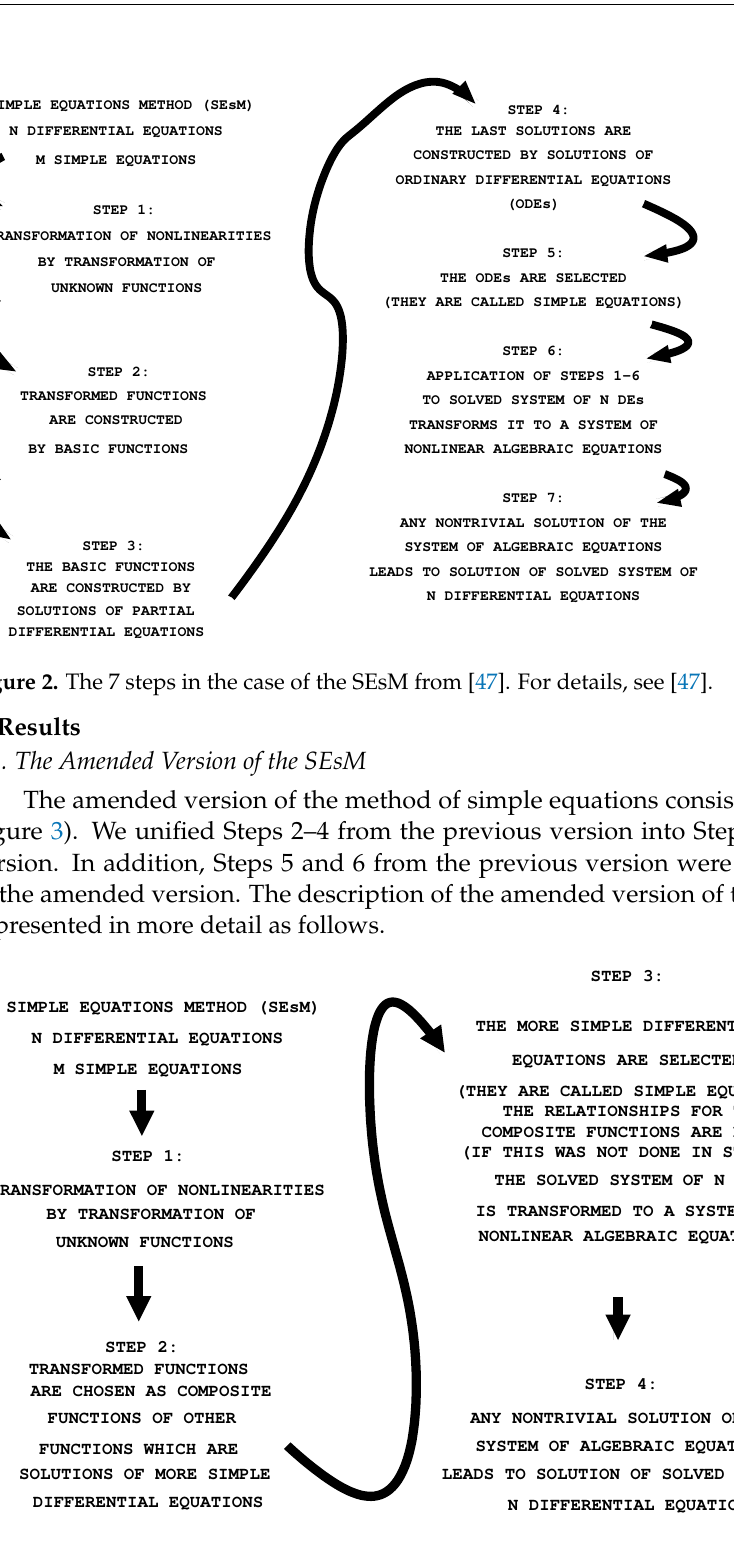
Figure 3. The version of the SEsM based on the use of composite functions. The composite function allows us to unify Steps 2–4 from Figure 2 into Step 2 here. In addition, Steps 5 and 6 from Figure 2 are unified into Step 3 here. Thus, the methodology becomes clearer. Instead of 7 steps, the new version of the SEsM consists of 4